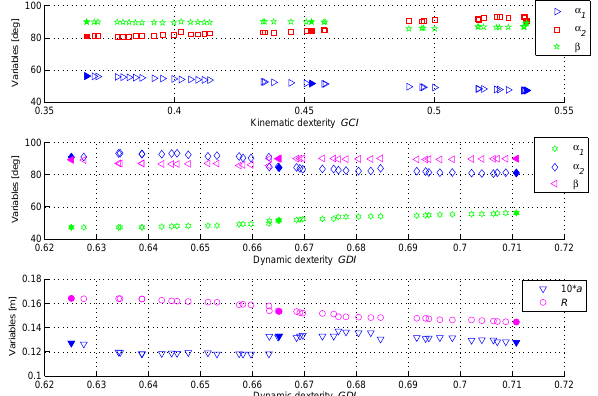
Figure 9: Design variables as functions of objectives for the Pareto-optimal